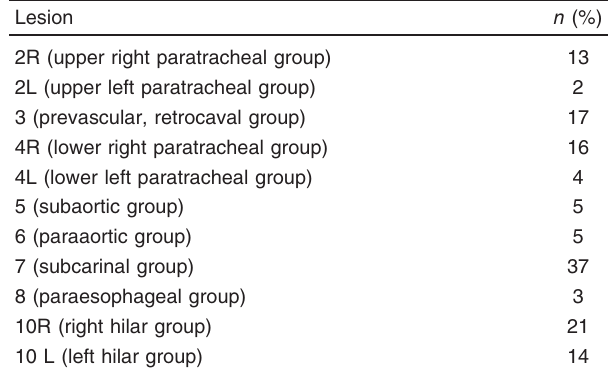
Table 3 Distribution of enlarged mediastinal and hilar lymph nodes among the cases